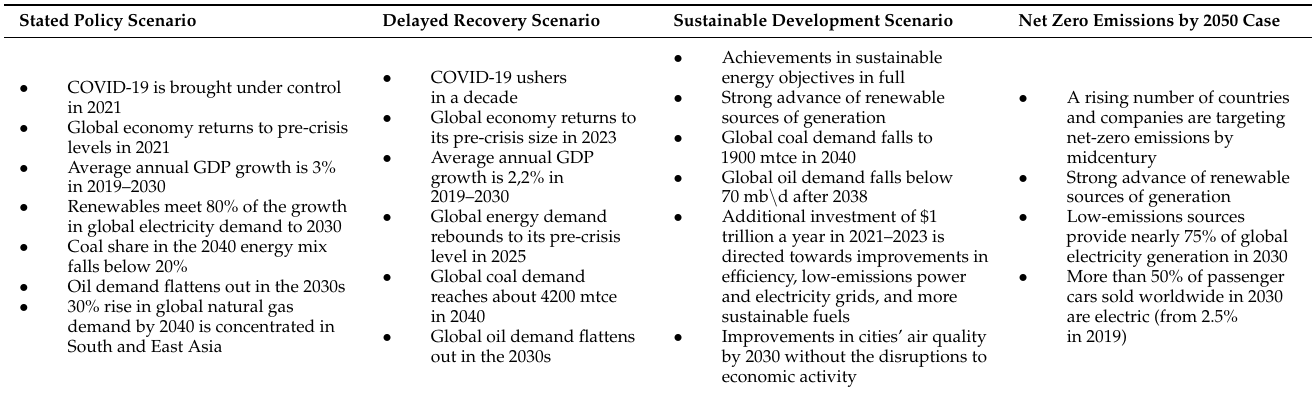
Table 2. Possible energy futures by IEA, 2020.